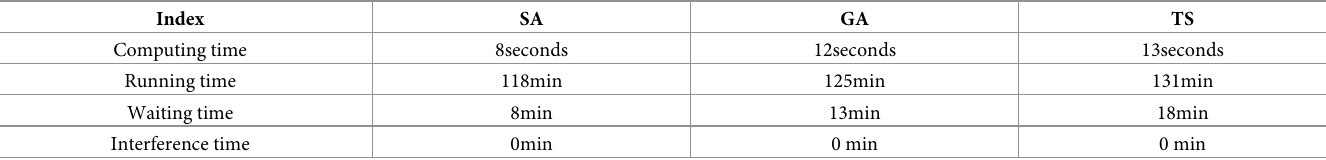
Table 6. Comparison of results of the three